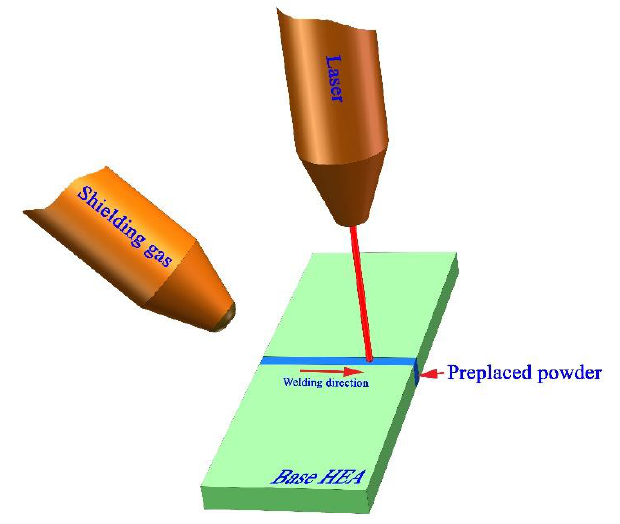
Figure 1. Schematic diagram of laser welding with preplaced powder.